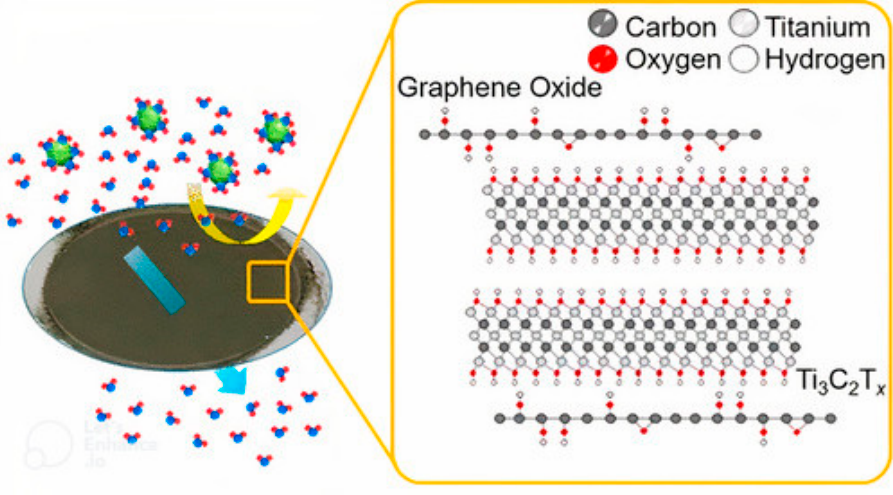
Figure 11. Structure of modified Ti 3 C 2 T x -based nanofiltration membranes [217]. A nano fi ltration membrane based on Ag nanoparticles and Ti 3 C 2 T x was reported by Pandy et al. [219]. Due to the role of Ti 3 C 2 T x as a reducing agent, Ag + ions are self-reduced, and Ag nanoparticles and nanopores form on the MXene surface, enhancing water move- ment. The membrane of Ag@MXene indicated increased permeances of 387.0, 354.0, and 345.0 LMH/bar for Rhodamine B, methyl green, and bovine serum albumin, respectively. There were rejection rates of approximately 93% for Rhodamine B, 92.32% for methyl green, and approximately 100% for BSA, which are similar to those of the Ti 3 C 2 T x neat membrane. Heterostructured Ti 3 C 2 T x MXene membranes with channels incorporating amalgamated CNTs studied by Dine et al. [202]. Due to the presence of CNTs, the fubri- cated membrane indicated 1270.0 LMH/bar water permeance, whereas a dead-end setup resulted in 97.3% and 100% rejection rates for rose bengal and crystal violet, respectively.